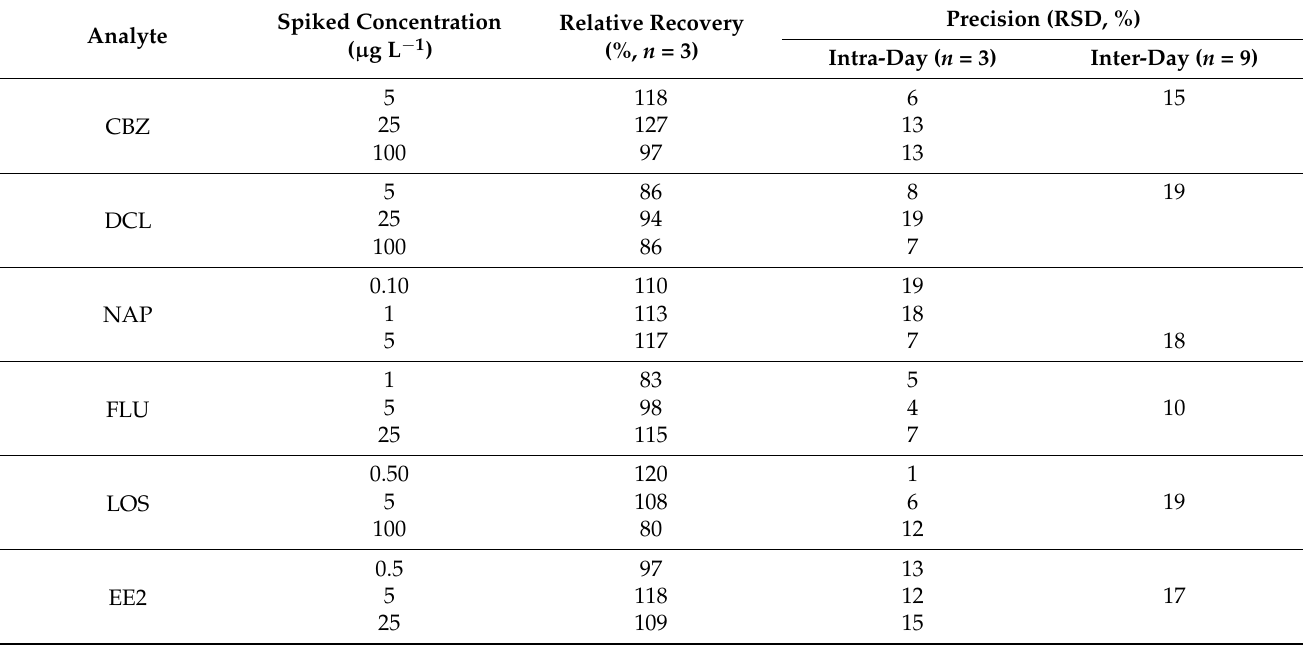
Table 3. Relative recovery, and intra and inter-day precisions for the pharmaceutical compounds in hospital wastewater using the fully optimized Si3Py + Cl − -DPX-based procedure.